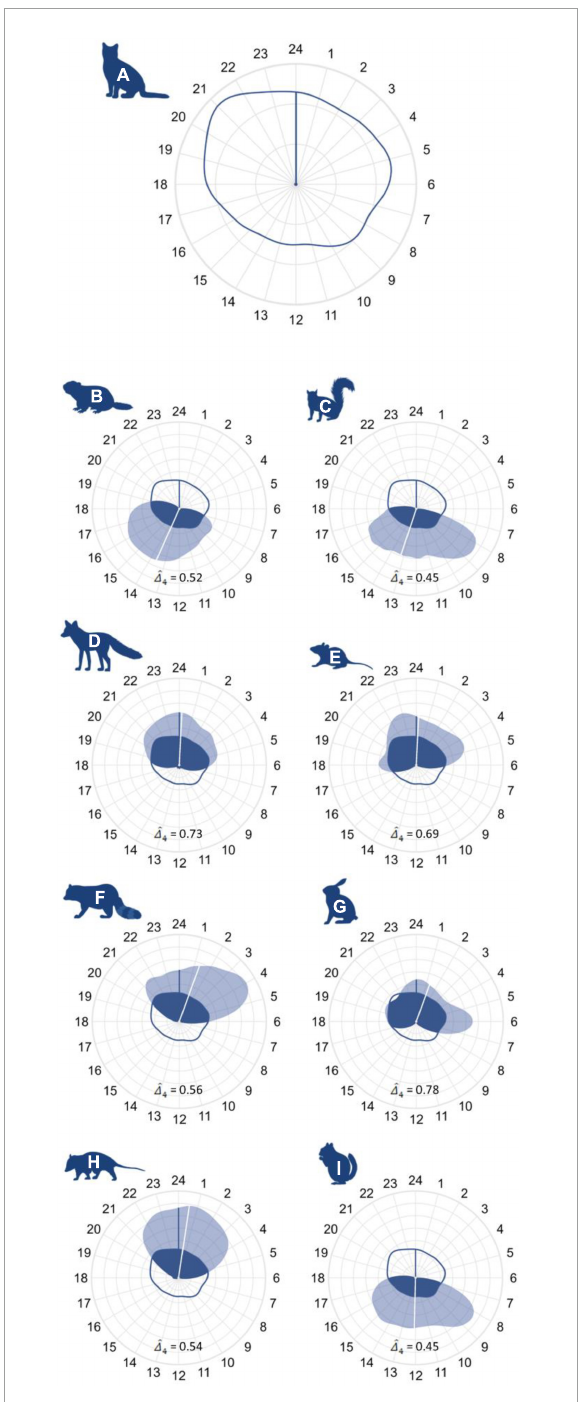
FIGURE5 Activity patterns and temporal overlap plotted on a 24 h clock for panel (A) cats, (B) groundhogs, (C) eastern gray squirrels, (D) red fox, (E) white-footed mice, (F) raccoon, (G) eastern cottontail, (H) , Virginia opossum, and (I) eastern chipmunk. Plots depict cat activity density and mean activity time using a dark blue line, while the light blue polygon and white line are used for the species of interest. Activity overlap (area beneath both curves) is colored in dark blue. Note that plot (A) utilizes a different scale than plots (B–I)